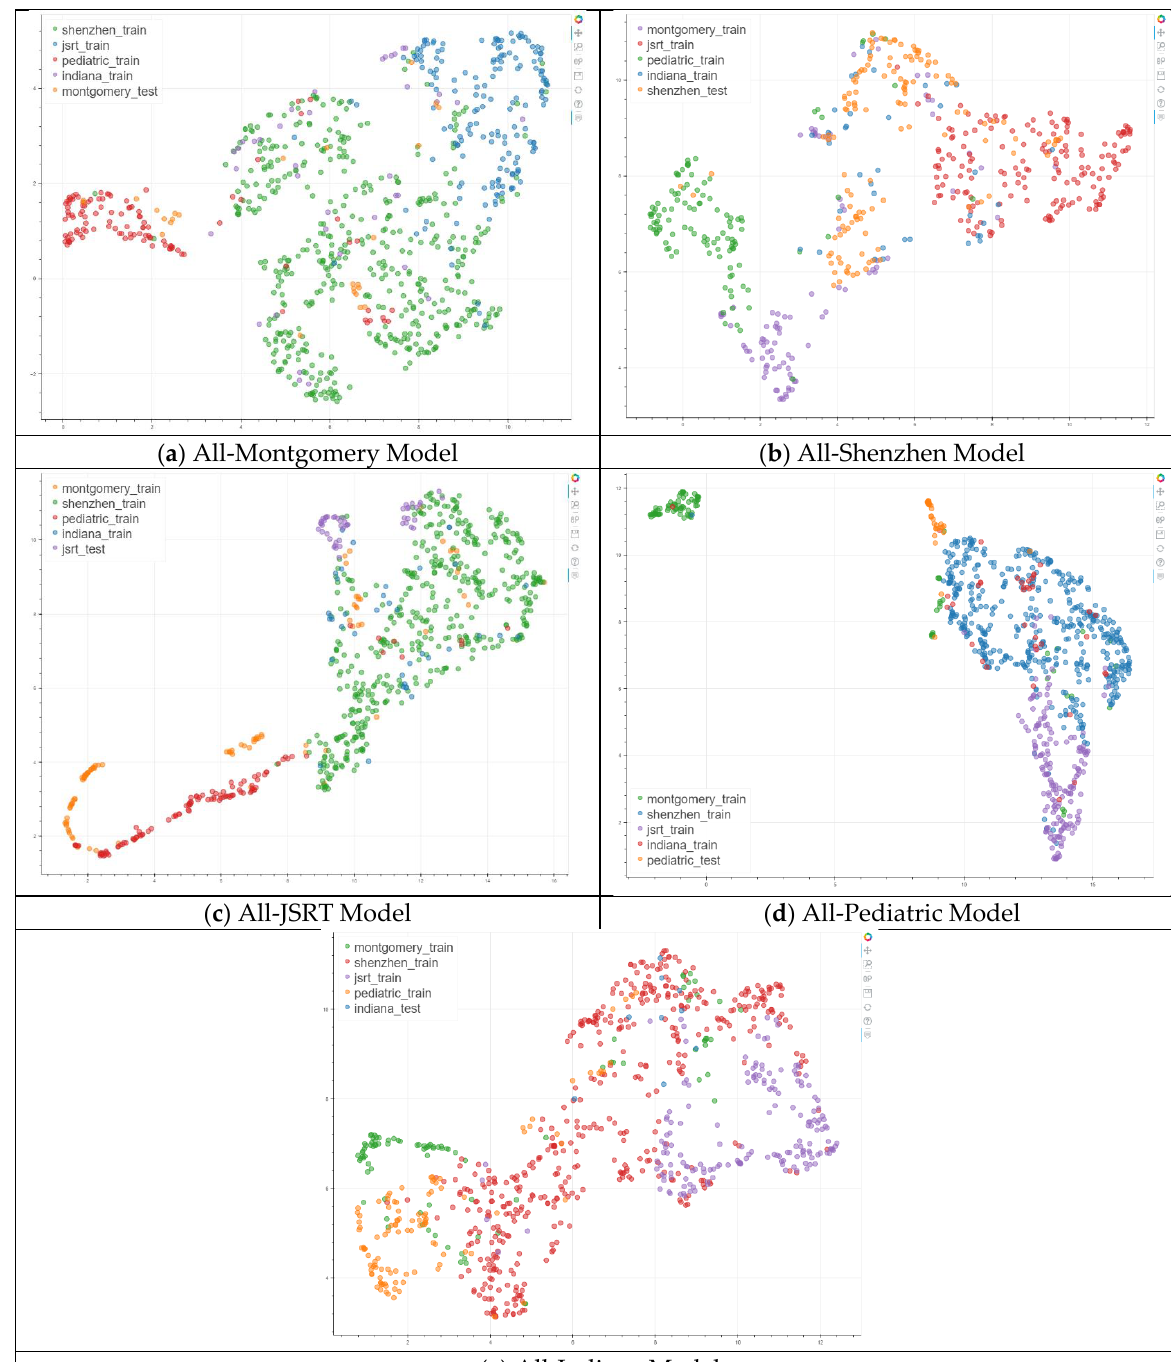
Figure A2. UMAP of YOLOv5 features extracted from All-one dataset models.